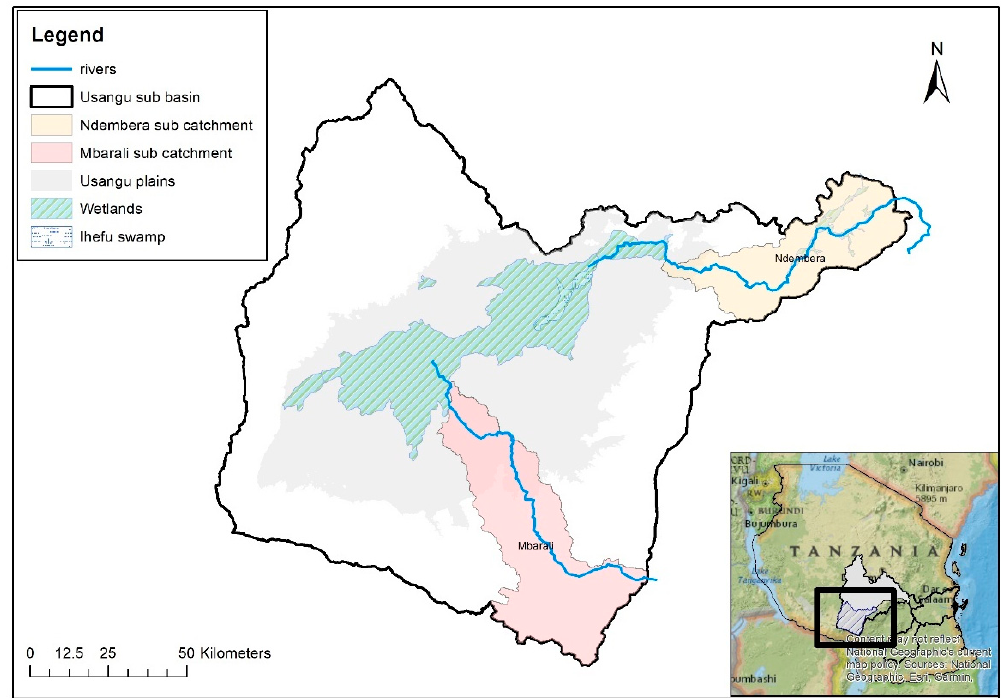
Figure 1. Mbarali and Ndembera rivers within the Usangu sub-basin, part of the Great Ruaha River Catchment (GRRC). Source: Produced by the author.